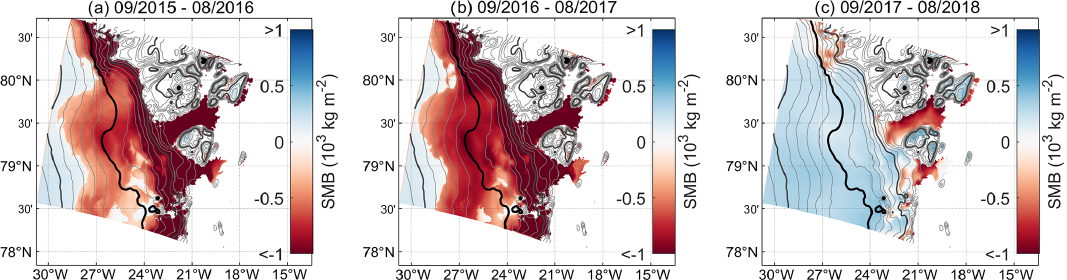
Figure 9. The annual surface mass balance of the 79 ◦ N Glacier and NEGIS region from September to the following August in 2015–2016 (a) , 2016–2017 (b) , and 2017–2018 (c) . There are no estimates for 2018–2019 as the PWRF simulation which is used as input to the COSIPY SMB model was only available until December 2018. The dark black contour marks 1000ma . s . l . and the grey contours are every 100m.